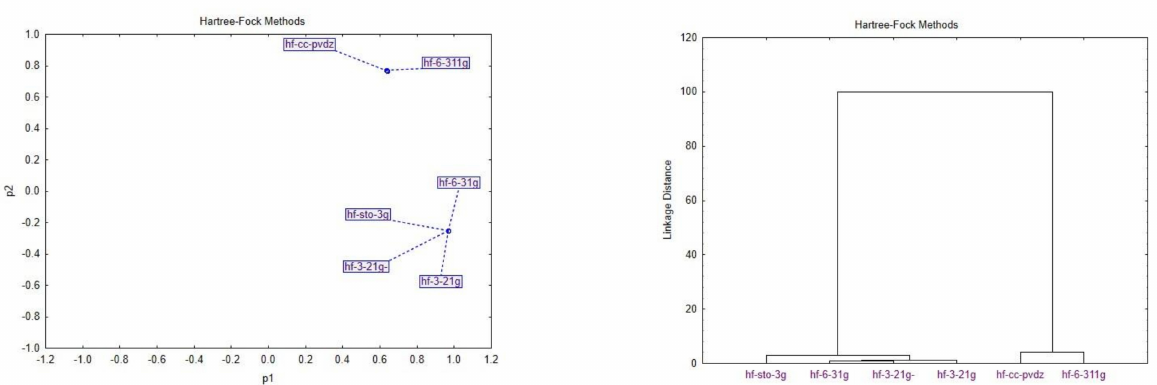
Figure 9. Score plot showing the distribution of the methods in the principal components p1 and p2 and cluster analysis.